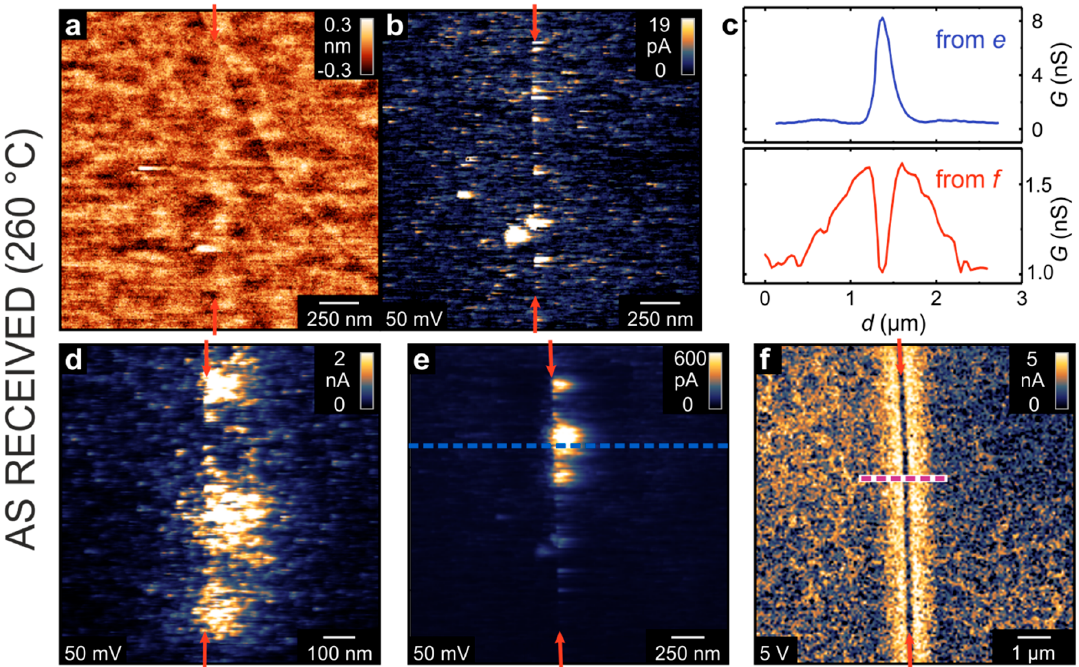
Figure 3. LC-AFM analysis of the surface in the vicinity of the 36.8° bicrystal junction measured at 260 °C. ( a ) Topography with ( b ) corresponding current map; ( d – f ) current maps obtained at different positions along the junction; ( c ) comparison of line profiles extracted from the current maps ( e ) and ( f ). The position of the boundary is marked by red arrows.